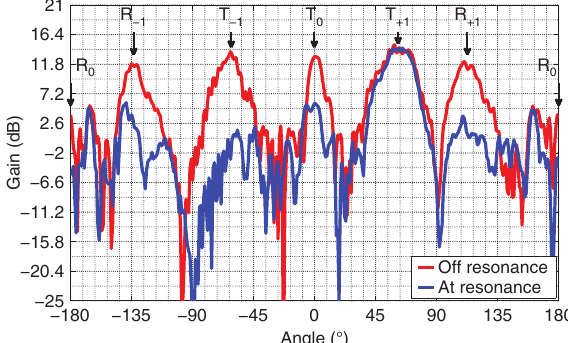
Figure 12: Measured far-field gain pattern (refractive properties) of a fabricated reflectionless bianisotropic metasurface for 0 ° to 71.8 ° refraction at 20 GHz. Obtained from Ref.